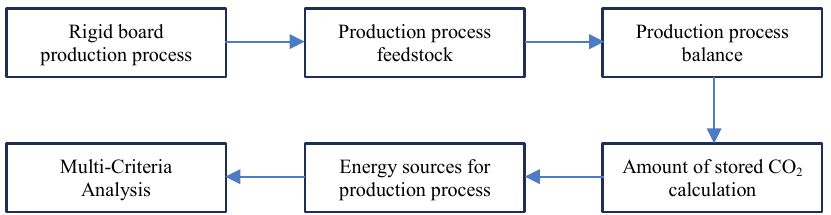
Multi-Criteria Analysis